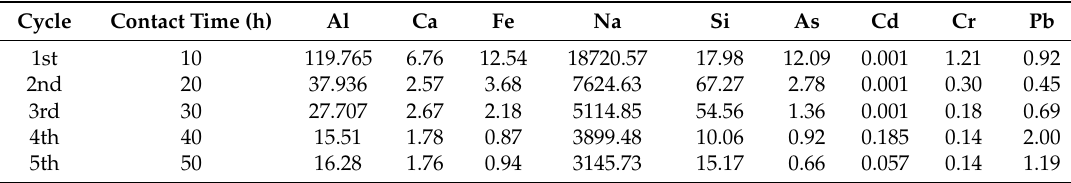
Table 6. Concentration (ppm) of leached